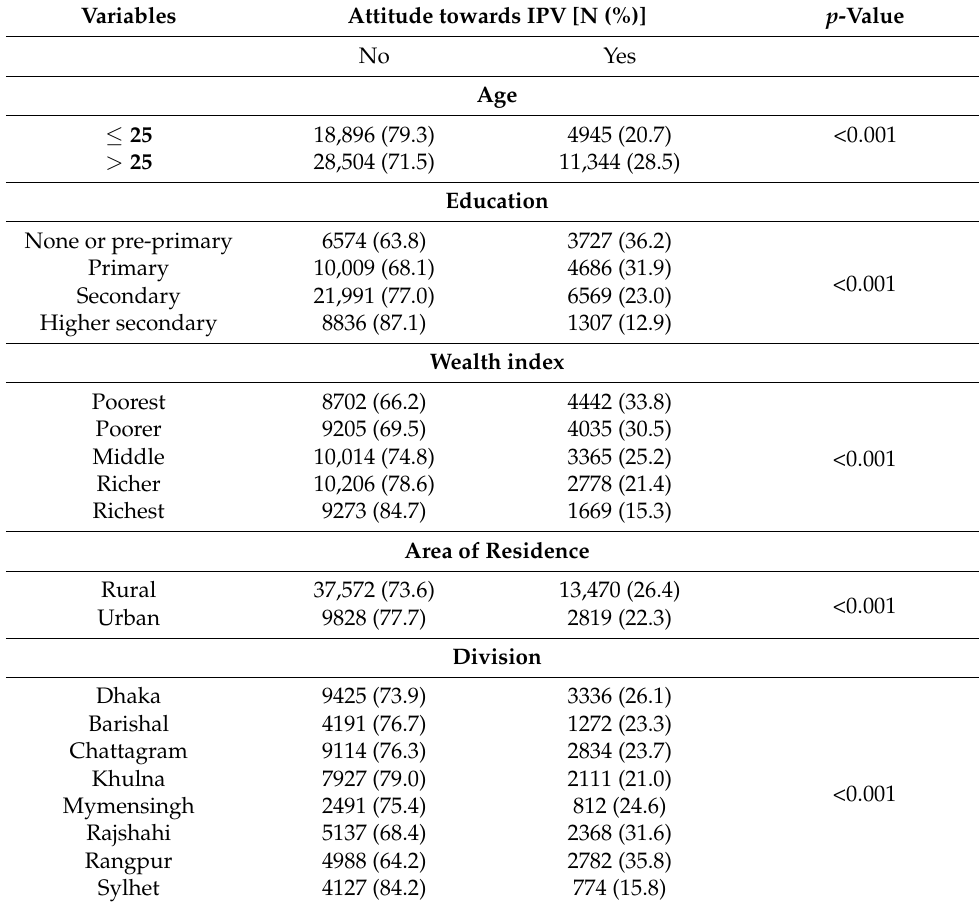
Table 2. Bi-variate association (unweighted) between attitude toward acceptance of IPV and the selected covariates; N =